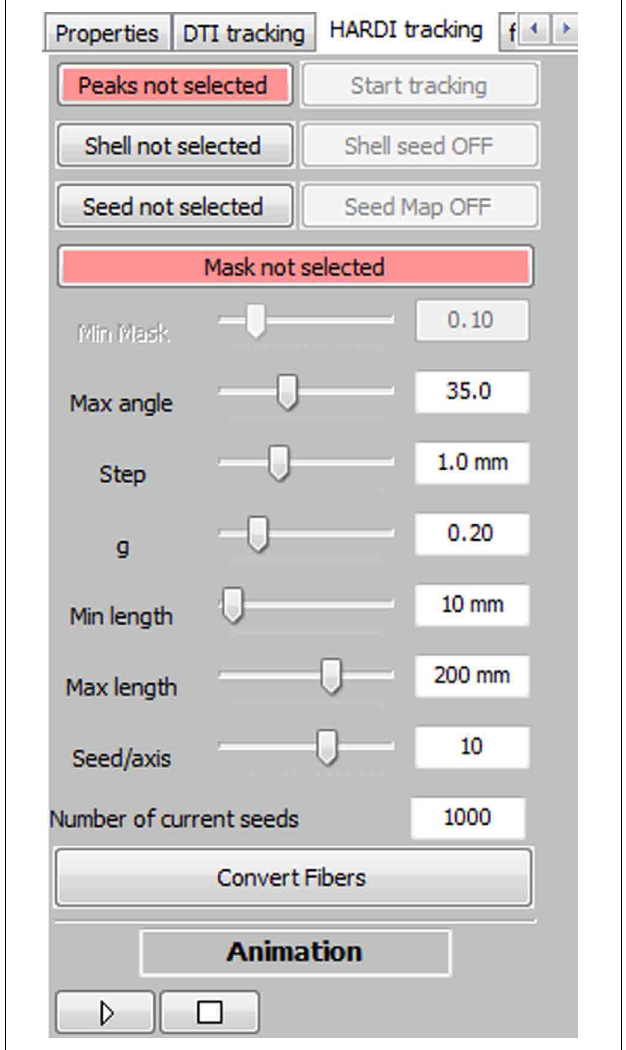
FIGURE 2 | Overview of the MultiPeak-RTT panel. The main fiber tracking parameters can be tuned interactively by the user, allowing a more in-depth comprehension of their effects on the resulting